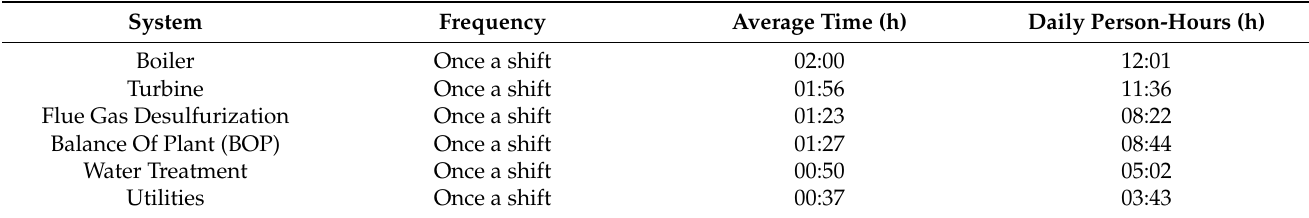
Table 2. Average time for carrying out the operational inspection